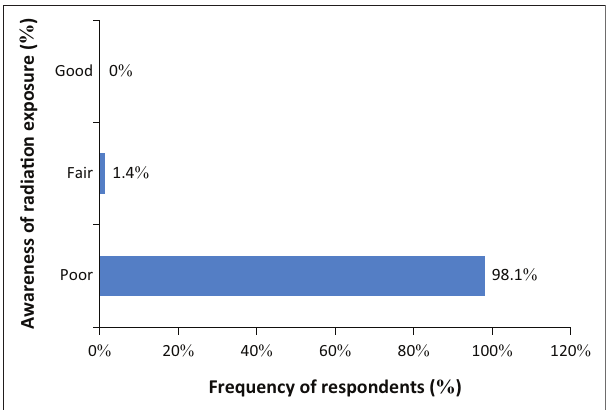
FIGURE 3: Respondents’ awareness of risk in diagnostic radiation.